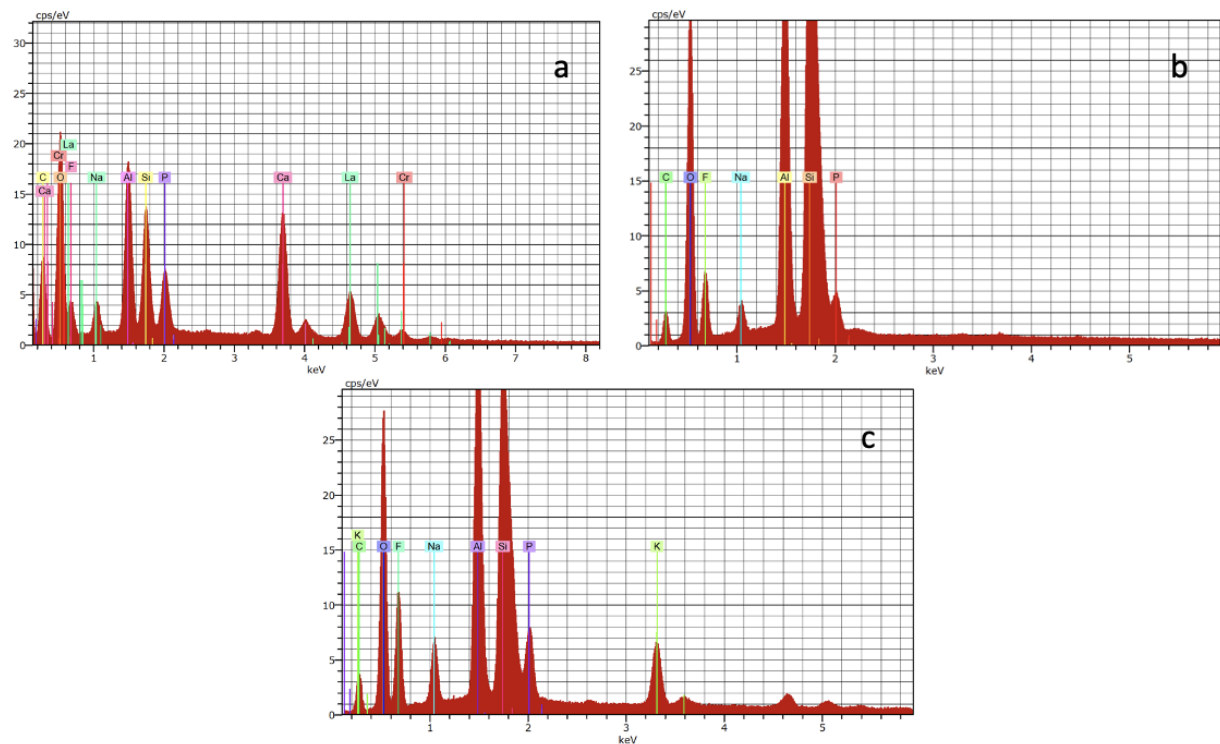
Figure 8. EDX analysis graphs of Ketac Molar ( a ), Riva Light Cure ( b ), and Equia Forte ( c ) pure at 28 days. Table 3. Percentage gain in Ca/P ratio (mol), calculated from EDX results, in dentin as a function of different materials, times, and thickness compared to non-demineralized